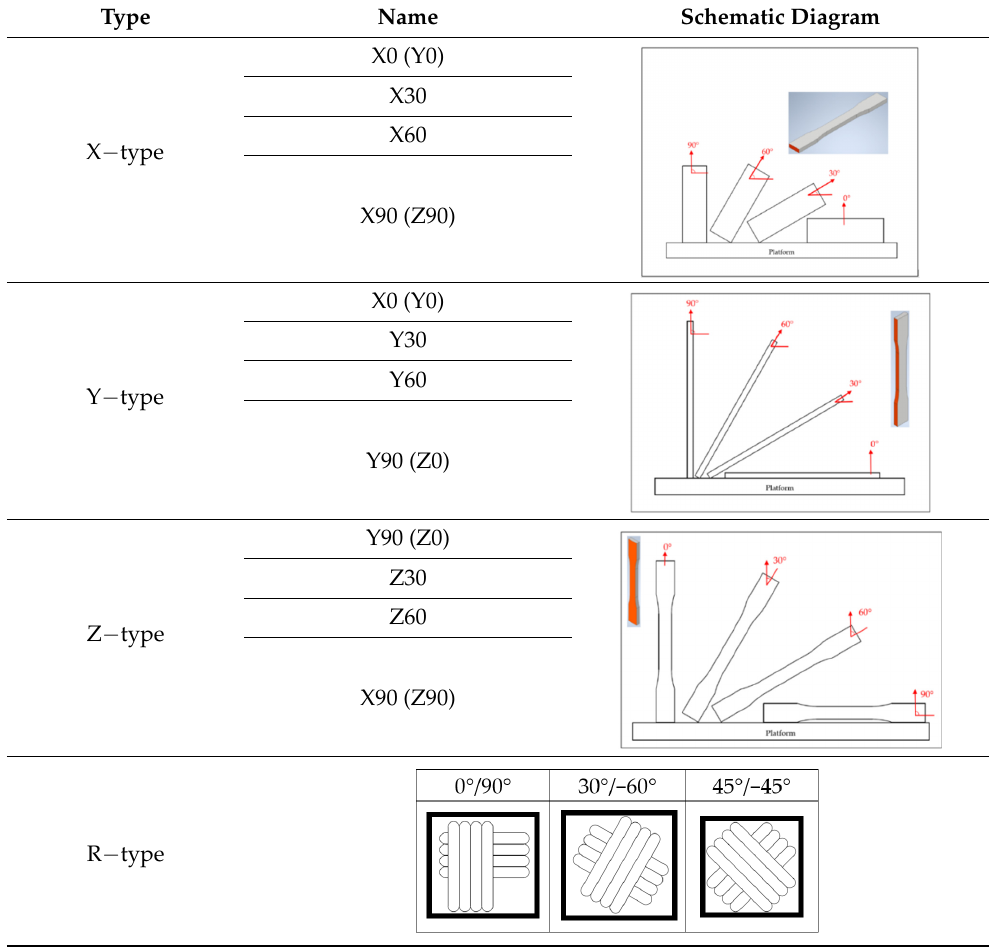
Table 2. The schematic diagram and definition of the test sample.